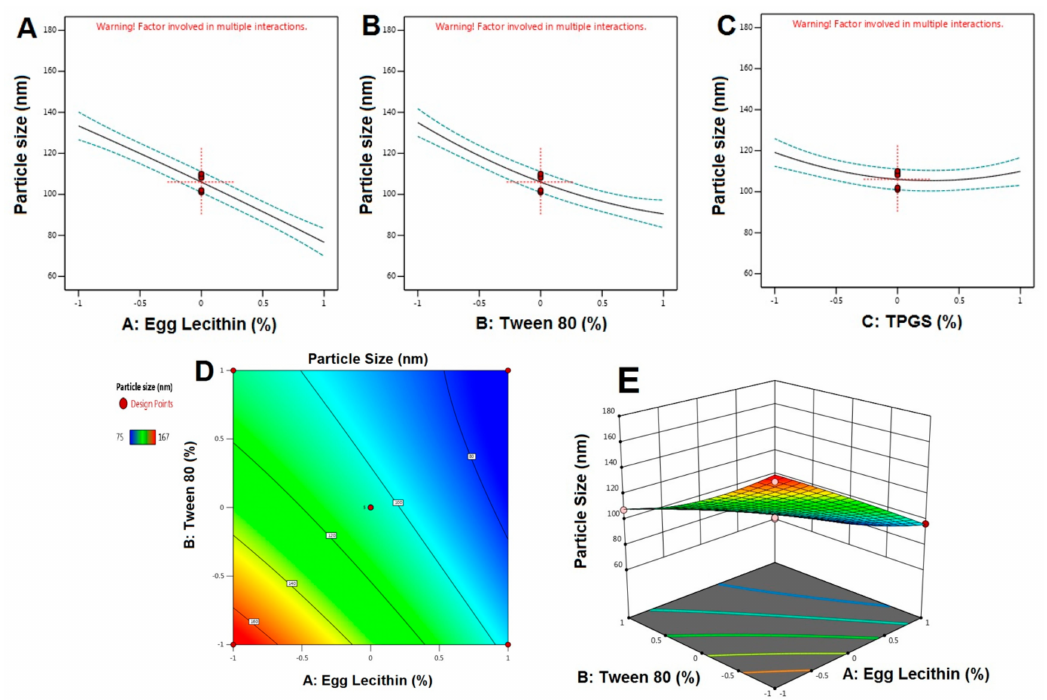
Figure 1. Main e ff ect diagram, contour, and 3-D response surface plots representing the e ff ect of the studied variables on particle size (Y1). ( A ). Main e ff ect diagram of Egg Lecithin (%) on particle size; ( B ). Main e ff ect diagram of Tween 80 (%) on particle size; ( C ). Main e ff ect diagram of TPGS (%) on particle size; ( D ). Contour Plot showing the e ff ect of Egg lecithin and Tween 80 on Particle size; ( E ). 3-D Surface plot representing the e ff ects of the egg lecithin (%) and tween 80 (%) on particle